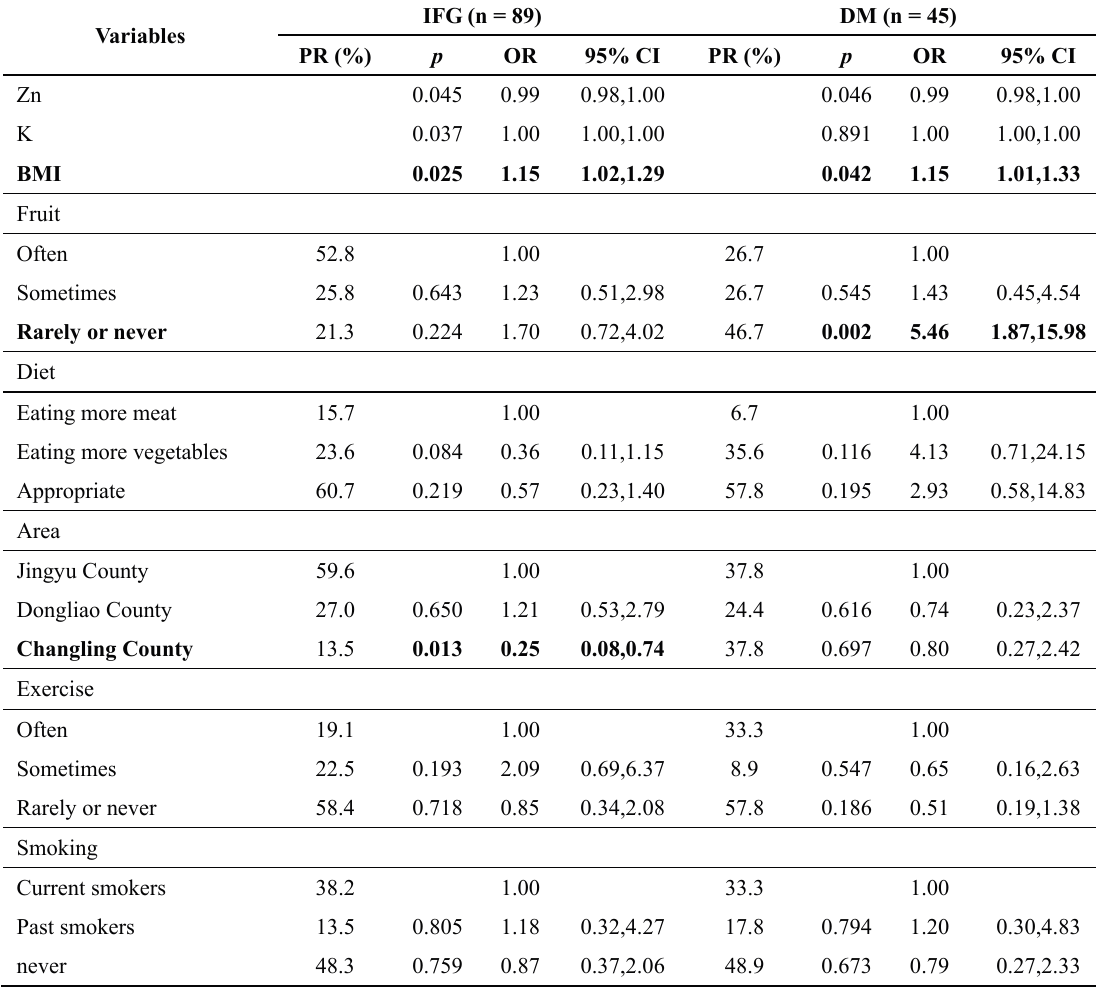
Table 5. Polytomous logistic regression analysis of factors influencing impaired glucose